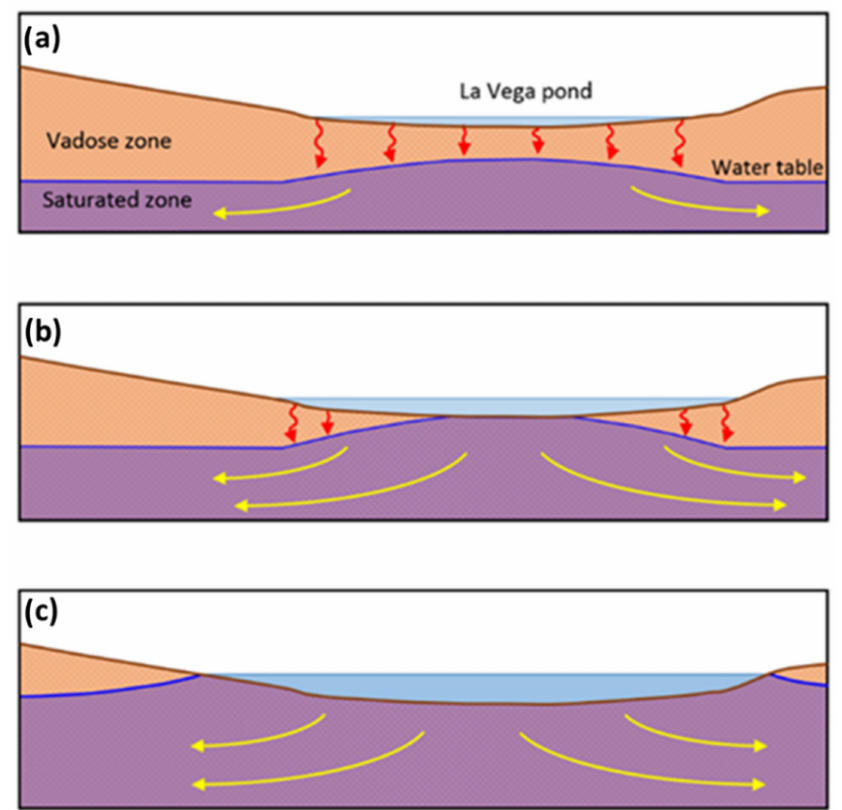
Figure 10. Simplified diagram of the three hydrodynamic situations that lead to differences in the infiltration rate. ( a ) The water stage is low and the piezometric level is below the pond ´ s bottom, favouring infiltration. ( b ) The piezometric surface bulges and reaches the bottom of the pond. Infiltration per unit section decreases. ( c ) The piezometric level reaches the pond stage. Infiltration ceases and water displays a horizontal, divergent radial